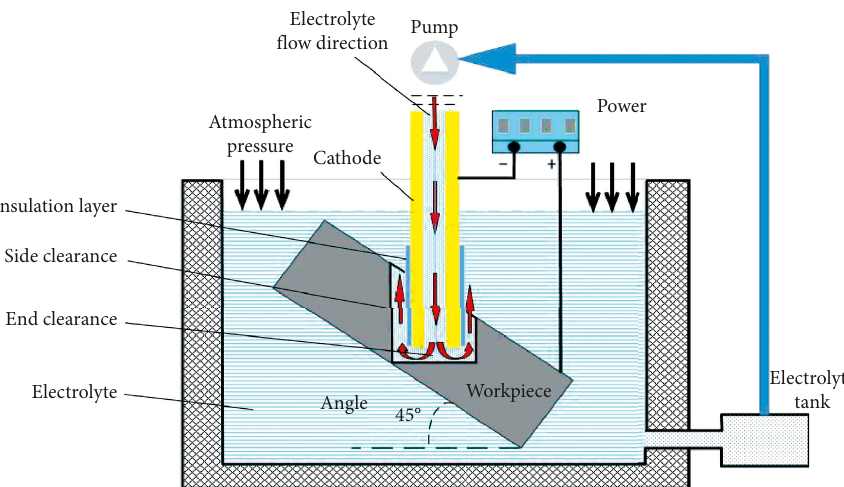
Figure 3: The schematic diagram of shaped tube electrochemical machining (STEM). Table 1: Chemical compositions of Inconel 718.